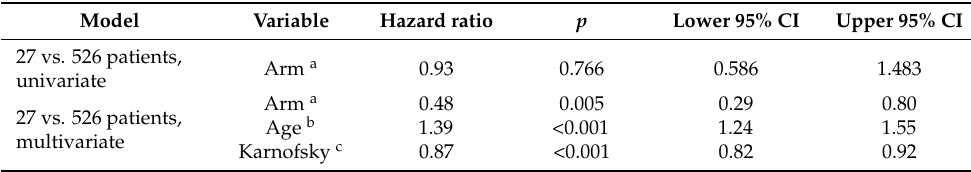
For comparison between non-study and study patients, different models were calcu- lated: (1) naïve comparison 27 vs. 526 and (2) comparison adjusted for KPS and age. The “naive” analysis of 27 non-study patients vs. the 526 patients of G-PCNSL-SG-1-study led to a hazard ratio of 0.93. After adjustment for age and KPS, the hazard ratio decreased to 0.48 ( p = 0.005, Table 3). Table 3. Comparison of survival in non-study vs. study patients Model Variable Hazard ratio p Lower 95% CI Upper 95% CI 27 vs. 526 patients, Arm a 0.93 0.766 0.586 1.483 univariate Arm 27 vs. 526 patients, multivariate